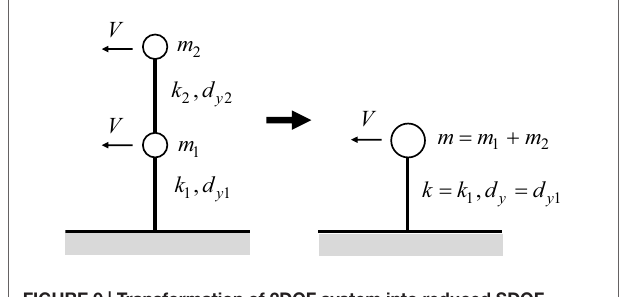
FigUre 9 | Transformation of 2DOF system into reduced sDOF